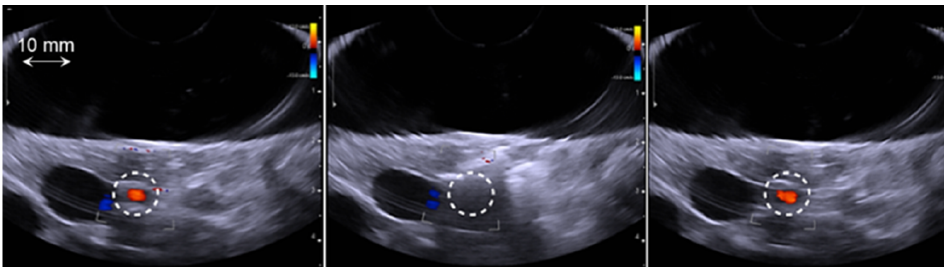
Figure 3. Typical example in group 4 of a temporary spasm. From left to right: Color Doppler imaging of the targeted artery (white circle) just before the HIFU treatment, just after the HIFU sonication and 12 min after the sonication. Normal blood flow was recovered on average 12 min after the temporary spasm in all cases.